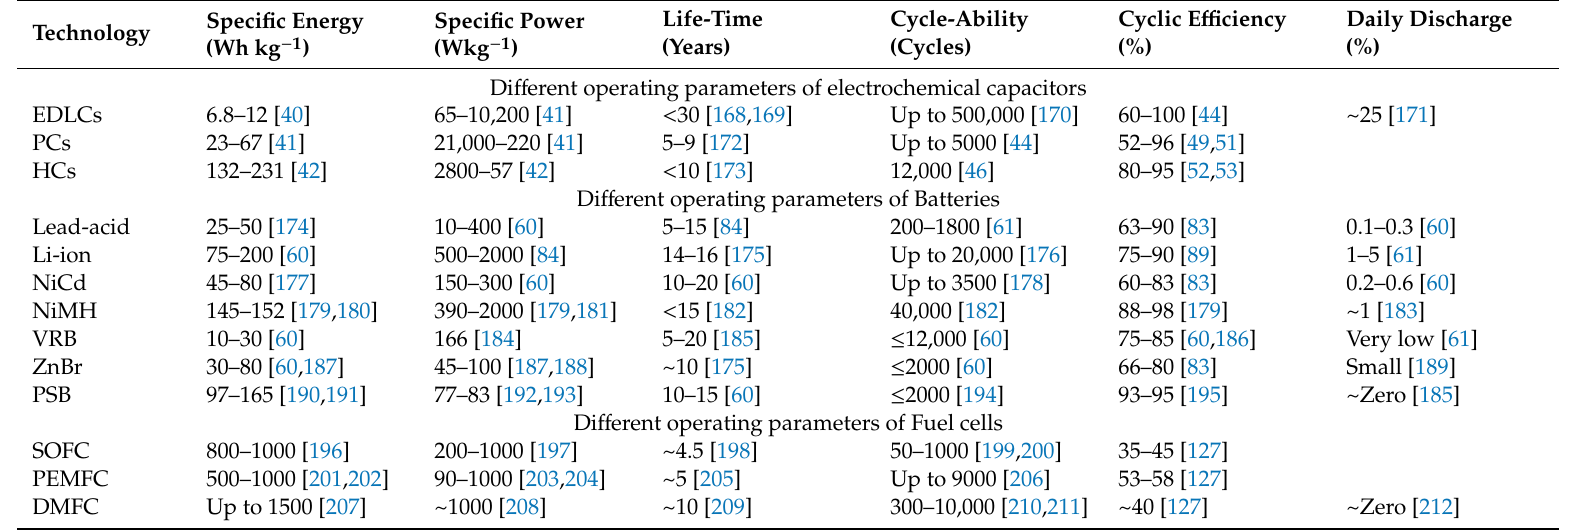
Table 9. Technical characteristics of key energy storage and conversion